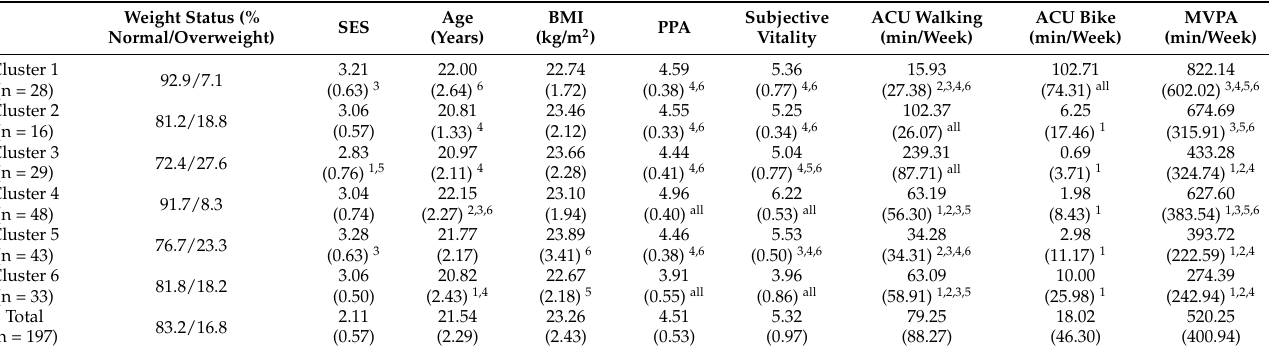
Table 5 ranks the mean values in the input variables of the respective clusters